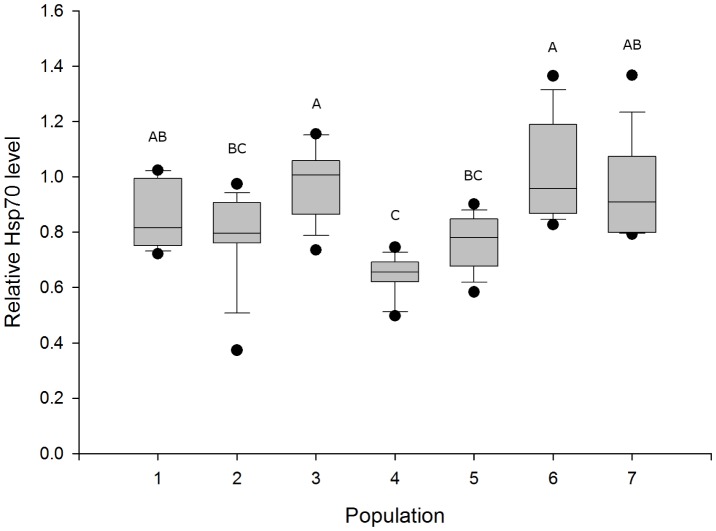
Comparison of Hsp70 levels after exposure to 40°C among populations.Different letters indicate statistically significant differences between groups. Data is plotted as the median, 10th, 25th, 75th, and 90th percentiles. Points show minimum and maximum values.